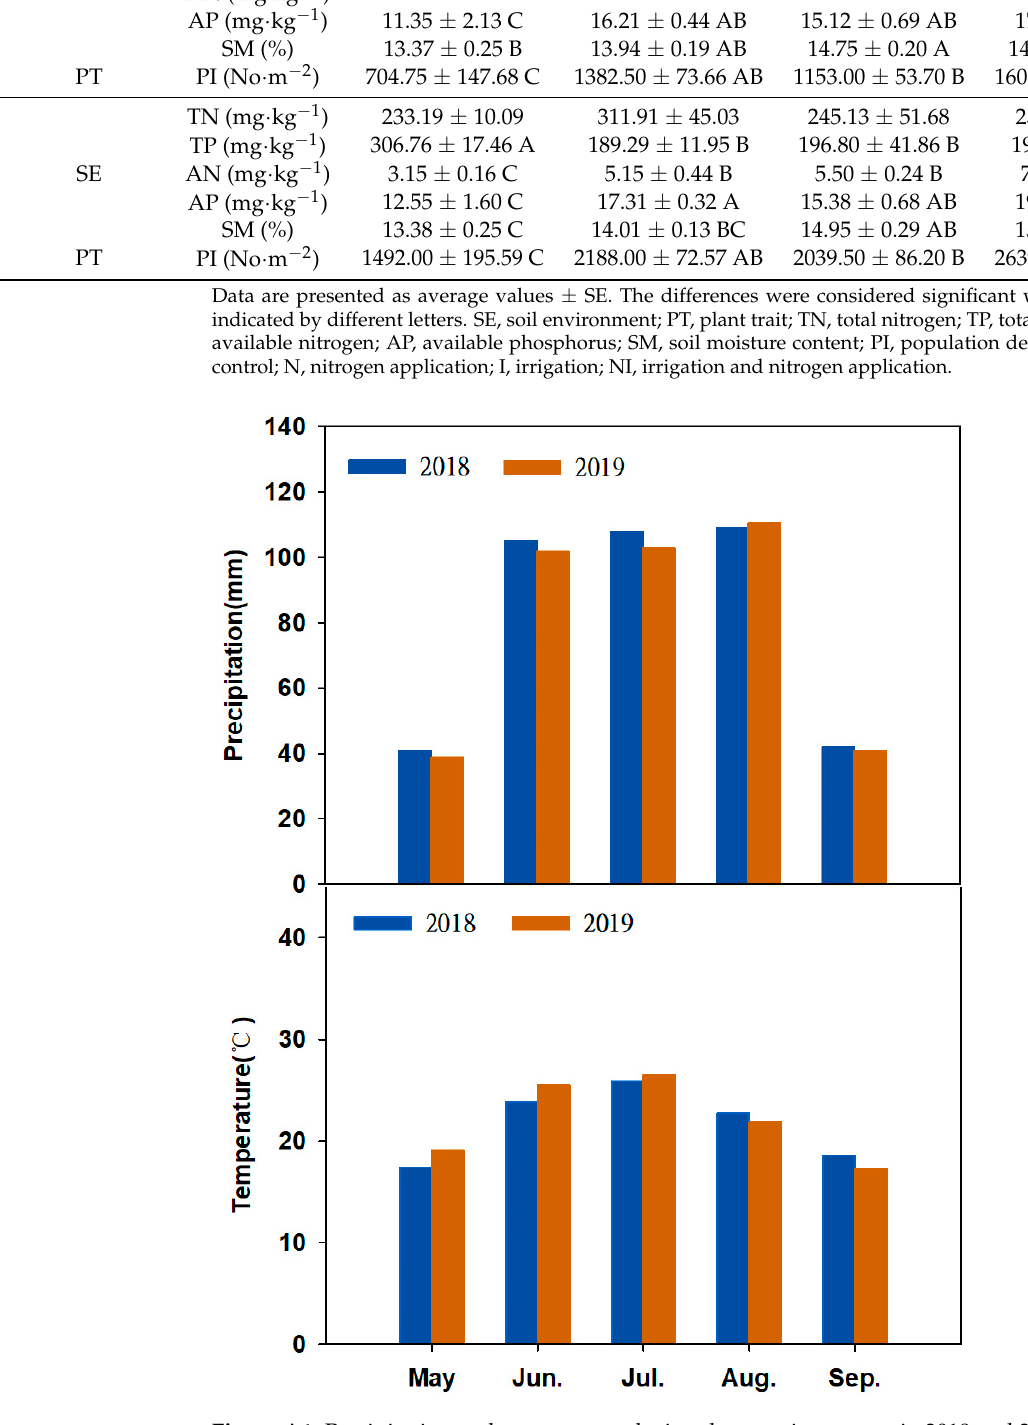
Figure A1. Precipitation and temperature during the growing season in 2018 and 2019.